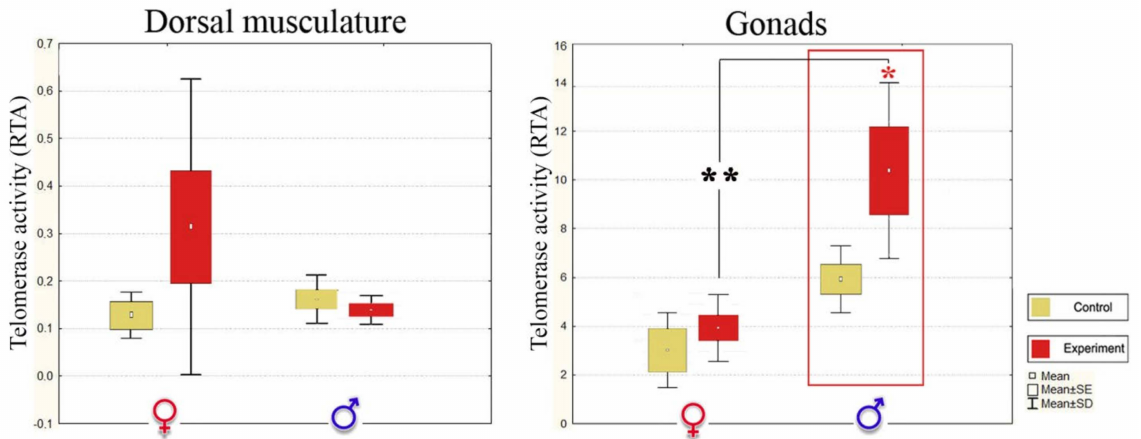
Figure 5. Relative telomerase activity (RTA) in different tissues of control and noise-exposed stone sculpin males and females. SD—standard deviation, SE—standard error. Statistically significant telomerase activity decrease was observed in the female auditory epithelium (inner ear), while a significant telomerase activity increase was recorded in male gonads upon noise exposure, marked with a red asterisk. Statistically significant differences between the sexes in the experimental group are shown with black asterisks: * p < 0.05, ** p < 0.01, Kruskal-Wallis